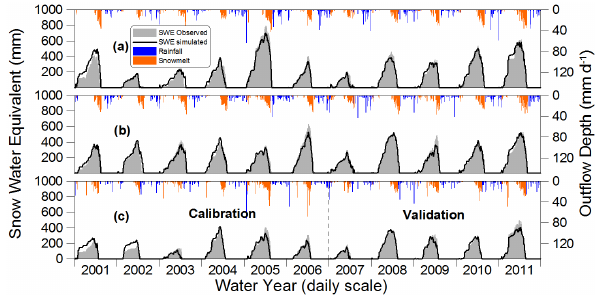
Fig. 4. Results from SNOW-17 at SNOTEL stations: (a) Castle Val- ley, (b) Pickle KEG, and (c) Vernon